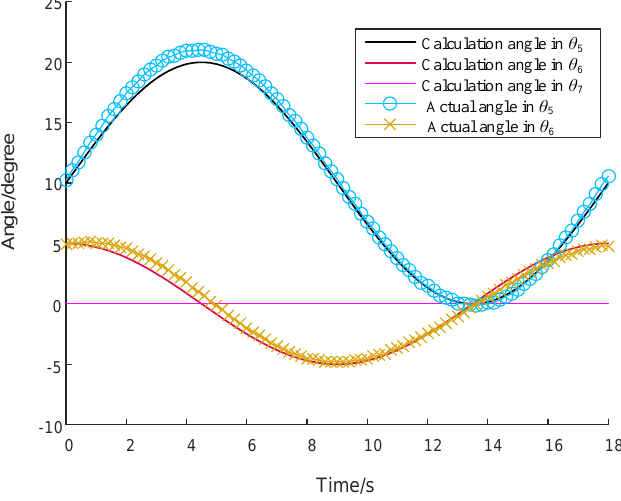
Figure 17. Comparisons of angles between the theoretical and the experiment.